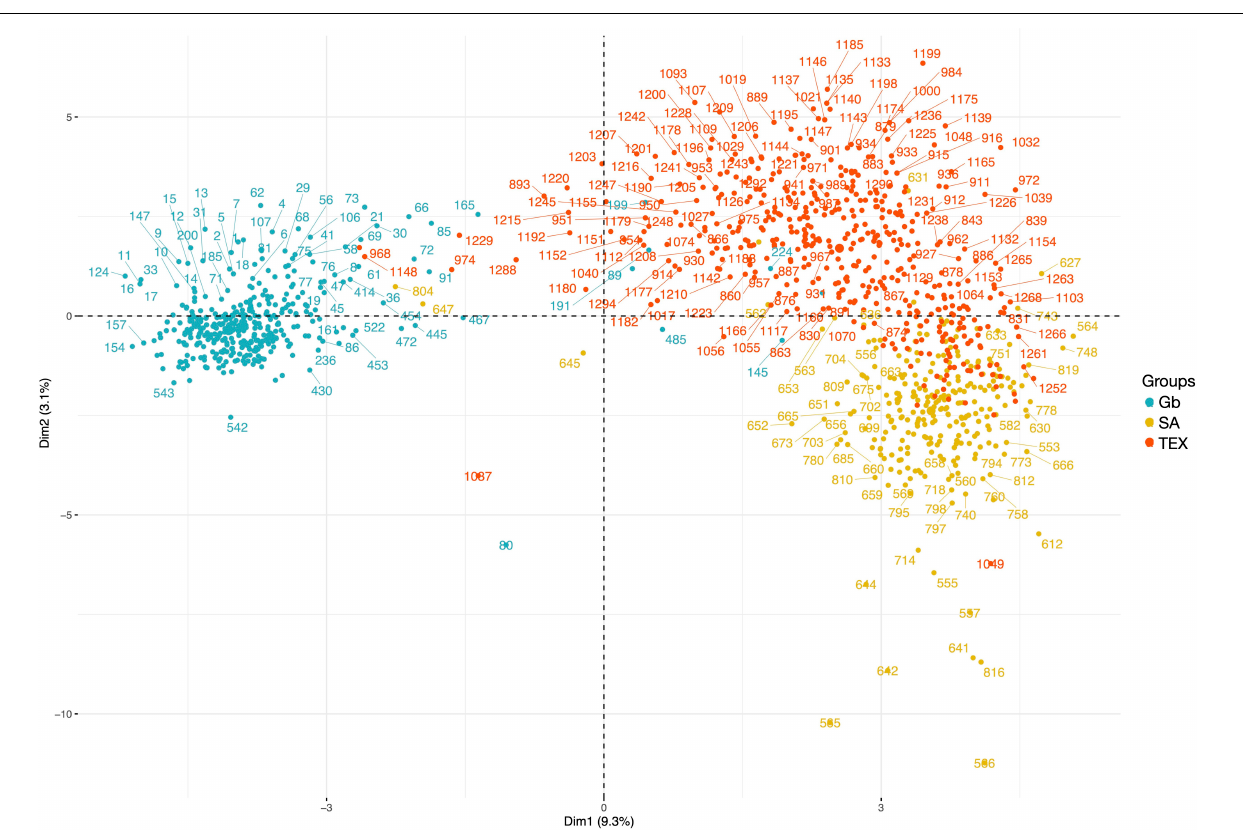
Supplementary Figure 9 ). The top contributing descriptors are boll color, bract color, and petal color ( Figure 9A ). The red dashed line indicates the expected average contribution (100% contribution divided by the total number of variables